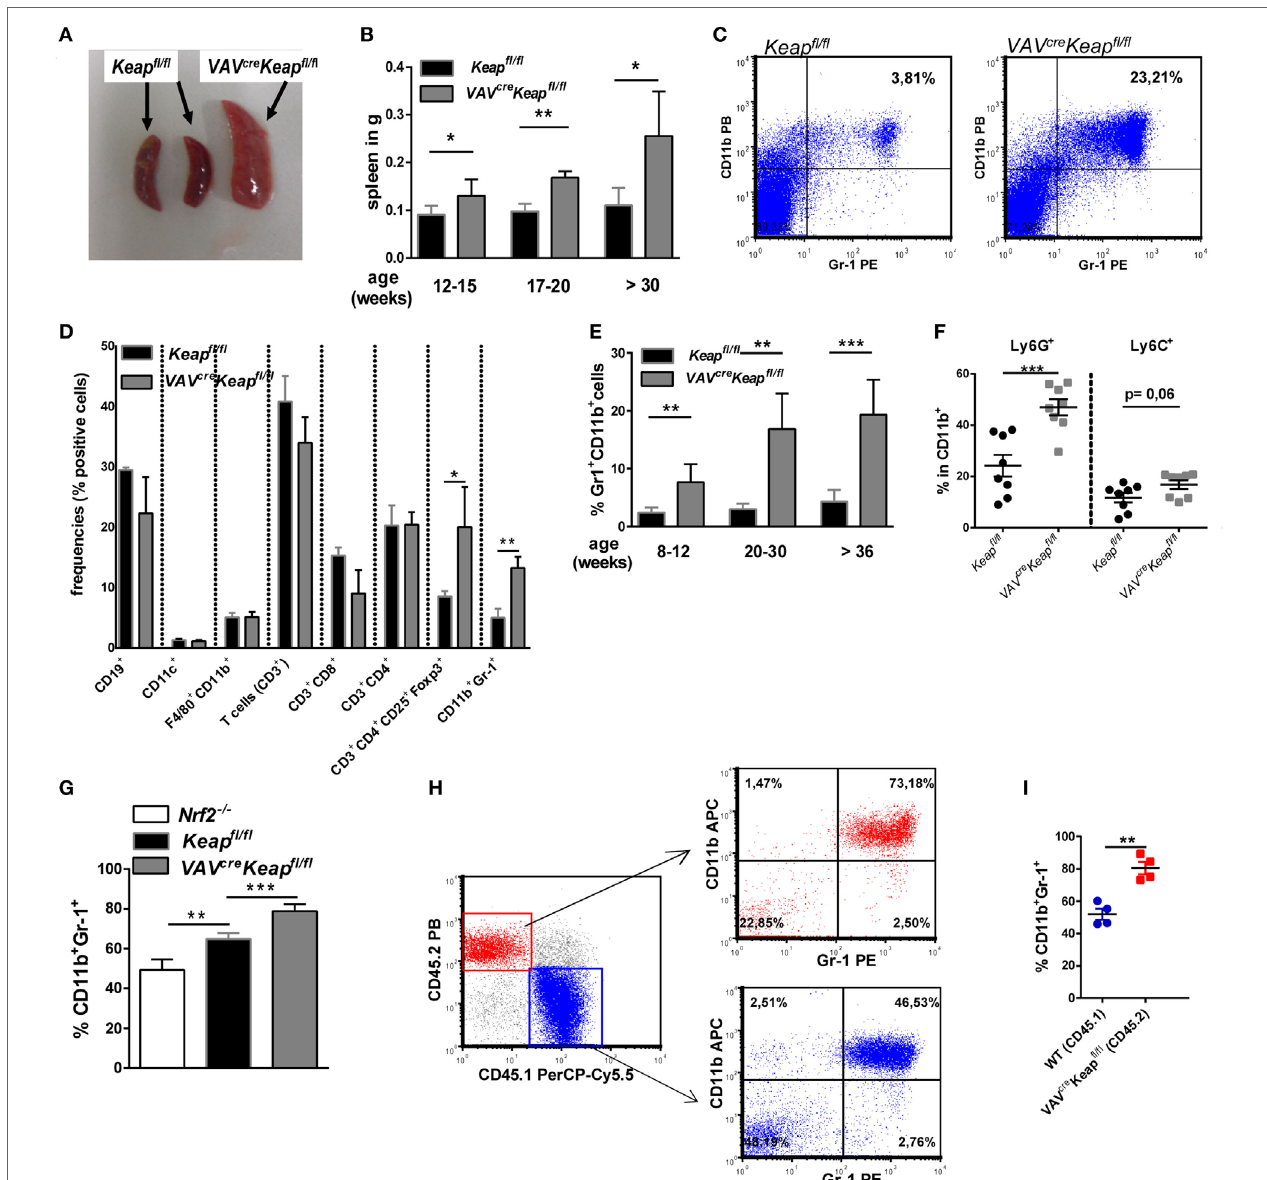
FigUre 1 | Nrf2 activation enhances CD11b + Gr-1 + cells. (a) Spleens from old (50–52 weeks) Keap fl/fl and VAV cre Keap fl/fl mice. (B) Weight of spleens from Keap fl/fl and VAV cre Keap fl/fl mice at different ages. Bars indicate mean ± SD of at least three mice per group. (c) Representative dot plot depicting frequencies of CD11b + Gr-1 + cells in spleens from old (50–52 weeks) Keap fl/fl and VAV cre Keap fl/fl mice. (D) Frequencies of immune cell populations in spleens from 16-week-old Keap fl/fl and VAV cre Keap fl/fl mice. Bars indicate mean ± SEM of three mice per group. (e) Frequencies of CD11b + Gr-1 + cells in spleens from Keap fl/fl and VAV cre Keap fl/fl mice at different ages. Bars indicate mean ± SD of at least six mice per group. (F) Frequencies of Ly6G + and Ly6C + cells within splenic CD11b + cells from Keap fl/fl and VAV cre Keap fl/fl mice. (g) BM-derived cells were incubated with GM-CSF and IL-6 and frequencies of CD11b + Gr-1 + cells were assessed by flow cytometry. Bars indicate mean ± SD of at least three mice per group. (h) Mixed BM chimeric mice were analyzed 8 weeks after transfer of CD45.1 WT and CD45.2 VAV cre Keap fl/fl BM cells into lethally irradiated RAG2 − / − recipient mice. WT mice were used, since Keap fl/fl CD45.1 mice were not available. Representative dot plots of splenic CD45.2 + Gr-1 + CD11b + and CD45.1 + Gr-1 + CD11b + cells are shown. (i) Percentages of splenic CD11b + Gr-1 + cells of CD45.1 and CD45.2 origin in bone marrow chimeras. For (F,i) , each symbol indicates an individual mouse. Horizontal lines represent the mean; error bars represent SEM. Two-tailed unpaired t -tests were used to determine p -values for all statistical